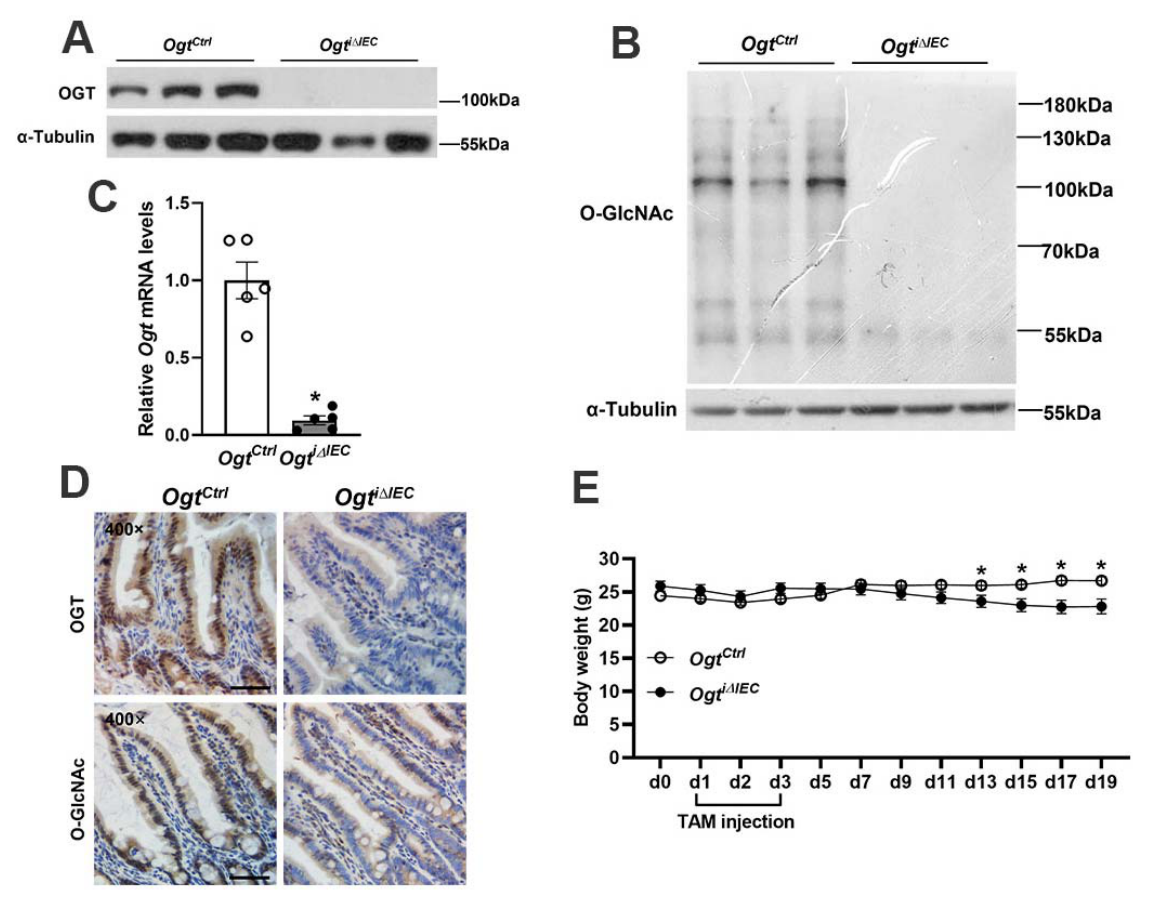
Figure 1. Generation of inducible IEC-specific Ogt knockout mice. The 6–9-week-old male Ogt Ctrl and Ogt i ∆ IEC mice were subjected to the following assays. ( A , B ) Western blot analysis of OGT ( A ) and O ‐ GlcNAcylation ( B ) in the jejunal IECs. ( C ) qPCR analysis of Ogt expression in the jejunal IECs ( n = 5/group). ( D ) IHC staining for OGT and O ‐ GlcNAcylation in the jejunum. ( E ) Body weight was monitored for a period of 20 days ( n = 8–9/group). Data are presented as mean ± SEM. * p < 0.05. Scale bars, 50 μ m.